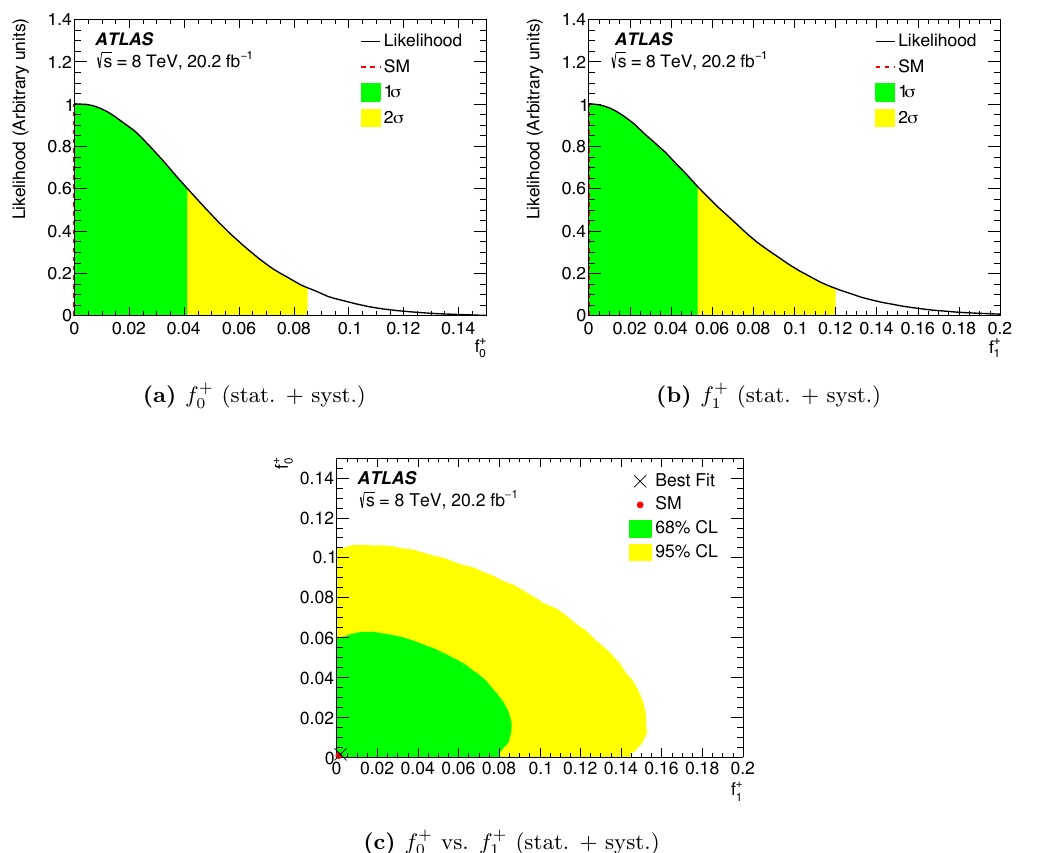
Figure 9. The likelihood pro(cid:12)les for the parameters (a) f + and (b) f + are shown. The black line 0 1 indicates the evaluated likelihood in each bin of the pro(cid:12)led variable. The red dashed line, which overlaps the y -axis, represents the SM expectation. Additionally (c), the joint likelihood pro(cid:12)le of f + as a function of f + is shown. The red point represents the SM expectation while a black x mark 0 1 indicates the observed value. Both points overlap with the origin of the x - and y -axis. The 68% and 95% CL regions are shown in green and yellow,